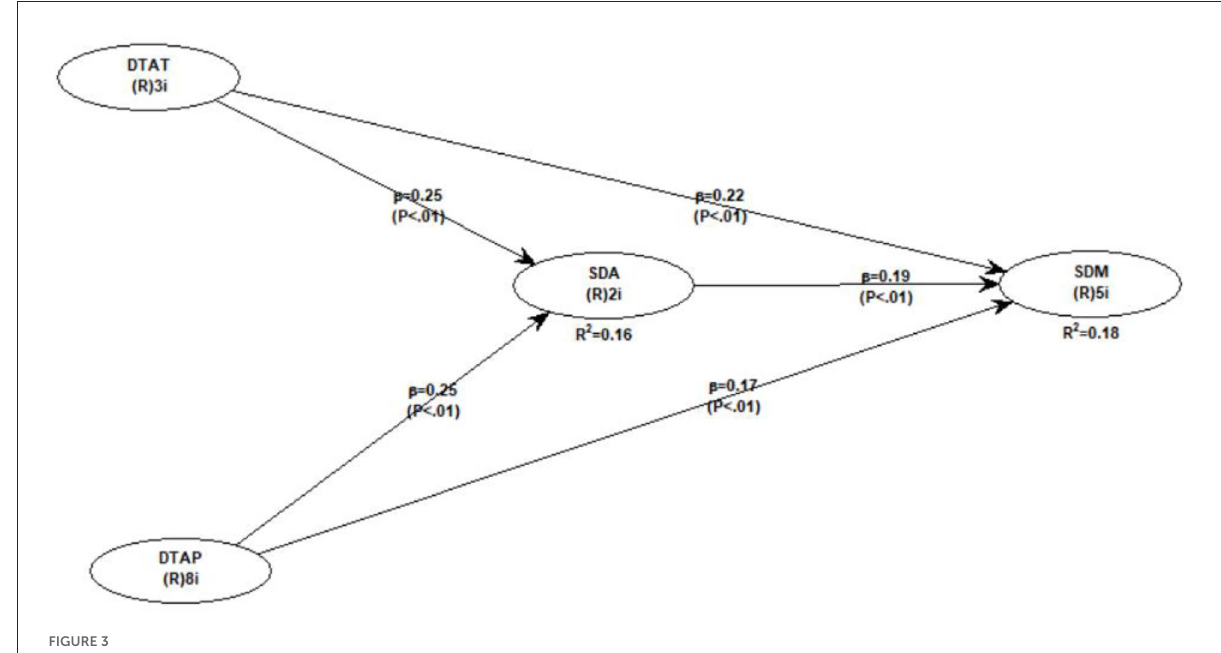
FIGURE3 Indirect model.